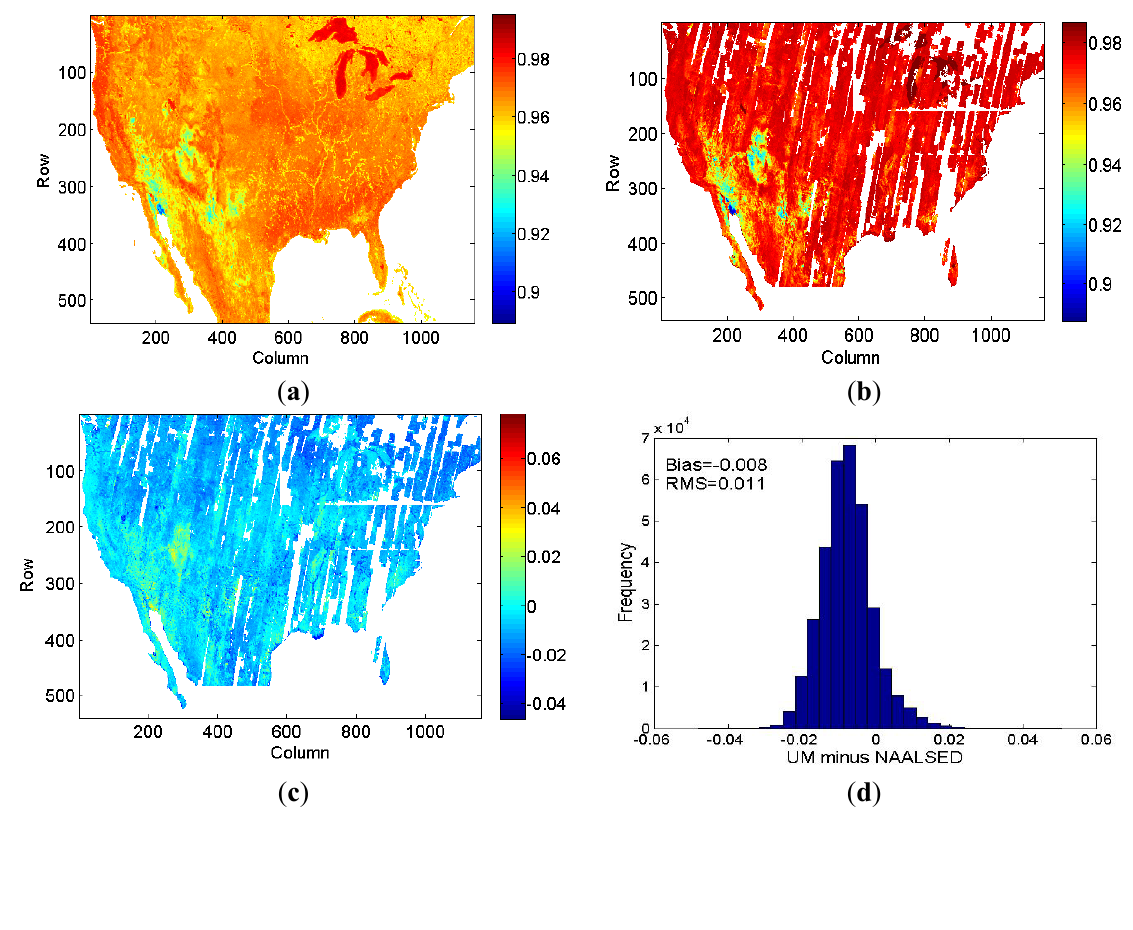
Figure 4. Comparison between NAALSED BBE and UWIREMIS BBE for the winter season. ( a ) UWIREMIS BBE; ( b ) NAALSED BBE; ( c ) the difference between UWIREMIS BBE and NAALSED BBE; ( d ) the histogram of the